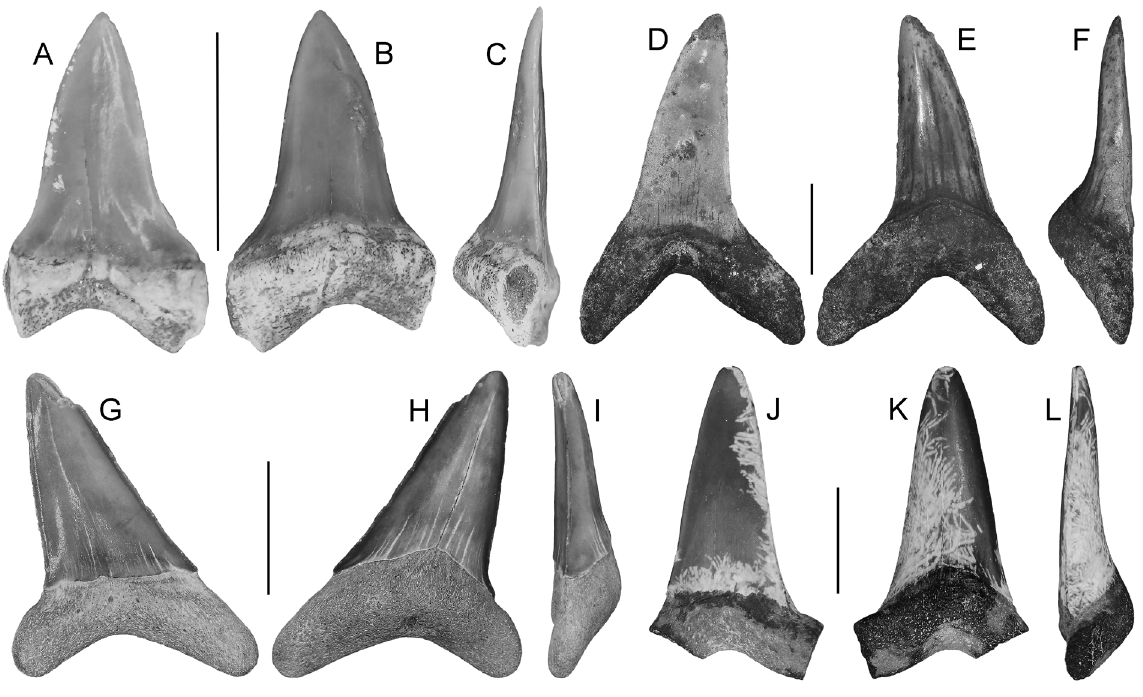
Fig. 20. Macrorhizodus praecursor (Leriche, 1905), teeth. A–C . MSC 35759, anterior tooth, lower Tallahatta Formation. A . Labial view. B . Lingual view. C . Distal view. D–F . MSC 37174,